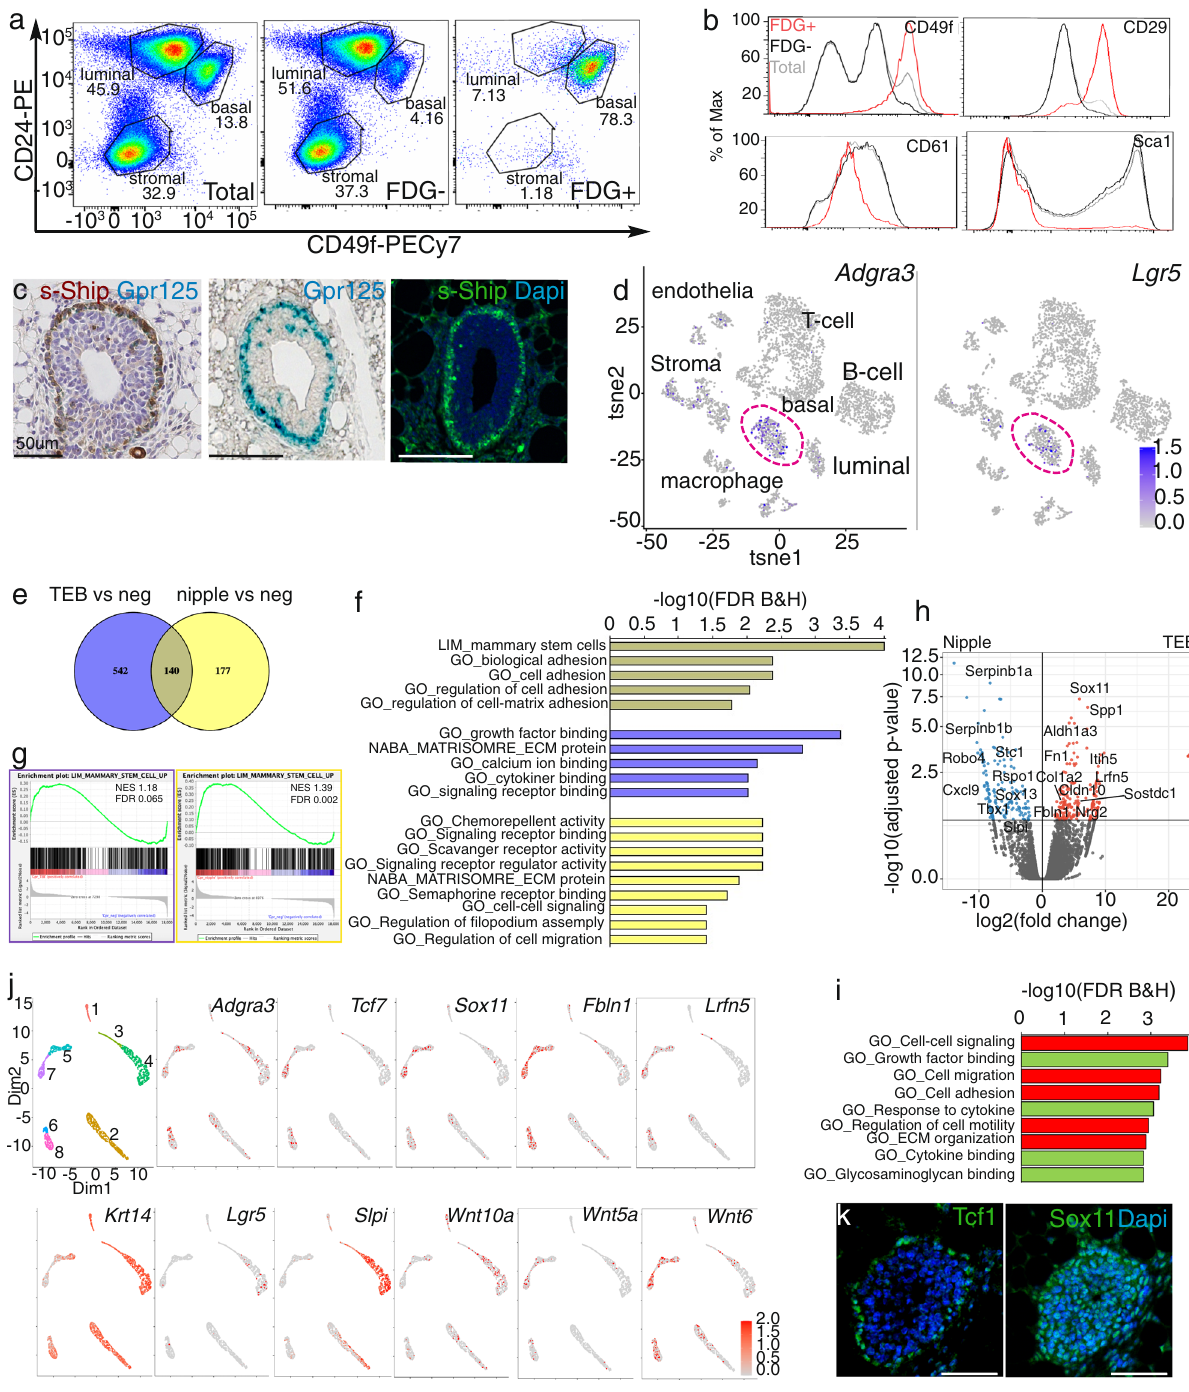
Transcriptomic pro fi ling of Gpr125 subpopulations . To gain involved in cell adhesion and regulation of cell-matrix adhesion further insight into the transcriptional pro fi le of Gpr125 + cell (Fig. 2f histogram gray). The TEB-distal Gpr125 + population was populations, we performed whole-genome RNAseq on Gpr125 + enriched in the expression of genes encoding proteins involved in (FDG + /CD49 hi ) and Gpr125- (FDG-/CD49 hi ) cells isolated from growth factor, calcium, and cytokine binding and ECM (Fig. 2f TEB-distal and nipple-proximal mammary regions of pubertal histogram purple), whereas the nipple-proximal Gpr125 + cells mice expressing the Gpr125- β -Gal. When compared to their were enriched in the expression of cell-cell signaling, cell Gpr125-negative counterparts, TEB-distal and nipple-proximal migration and guidance and chemo-repulsion factors (Fig. 2f populations shared a core of 140 differentially expressed genes histogram yellow). Gene set enrichment analysis (GSEA) con- fi rmed that both TEB-distal and nipple-proximal Gpr125 + (Fig. 2e, Venn Diagram). Gene Ontology (GO) analysis revealed enrichment within this common core of genes encoding proteins populations are signi fi cantly enriched in the Mammary Stem NATURE COMMUNICATIONS| (2022) 13:1421